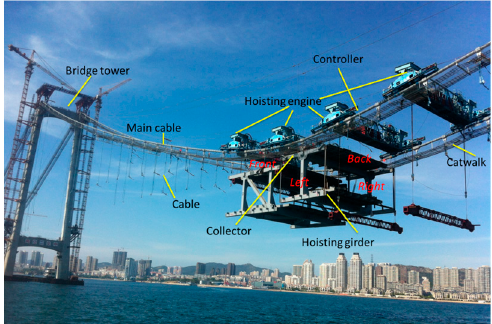
Figure 21. On-site hoisting of the middle span.